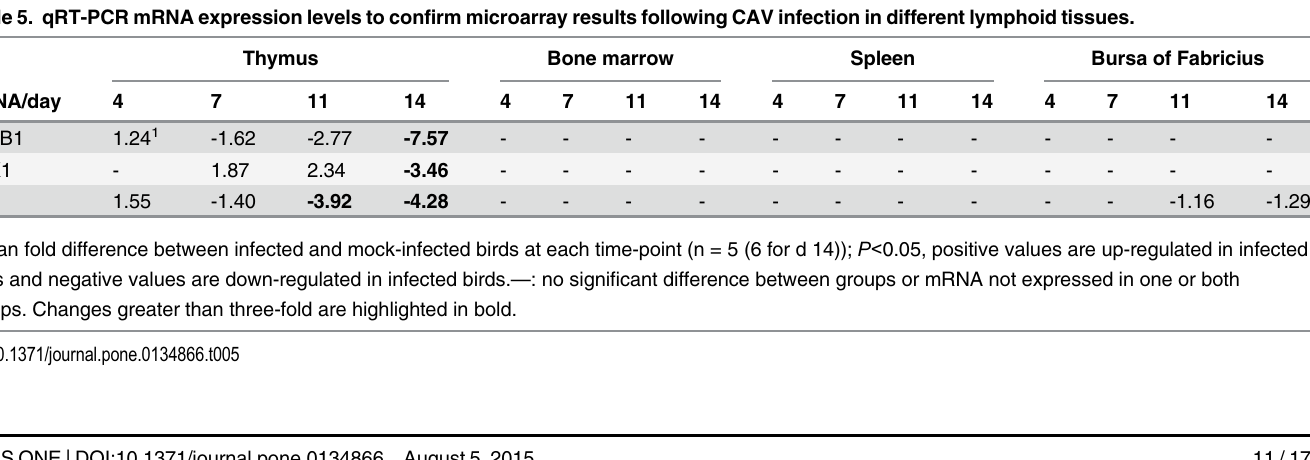
PLOS ONE | DOI:10.1371/journal.pone.0134866 August 5,